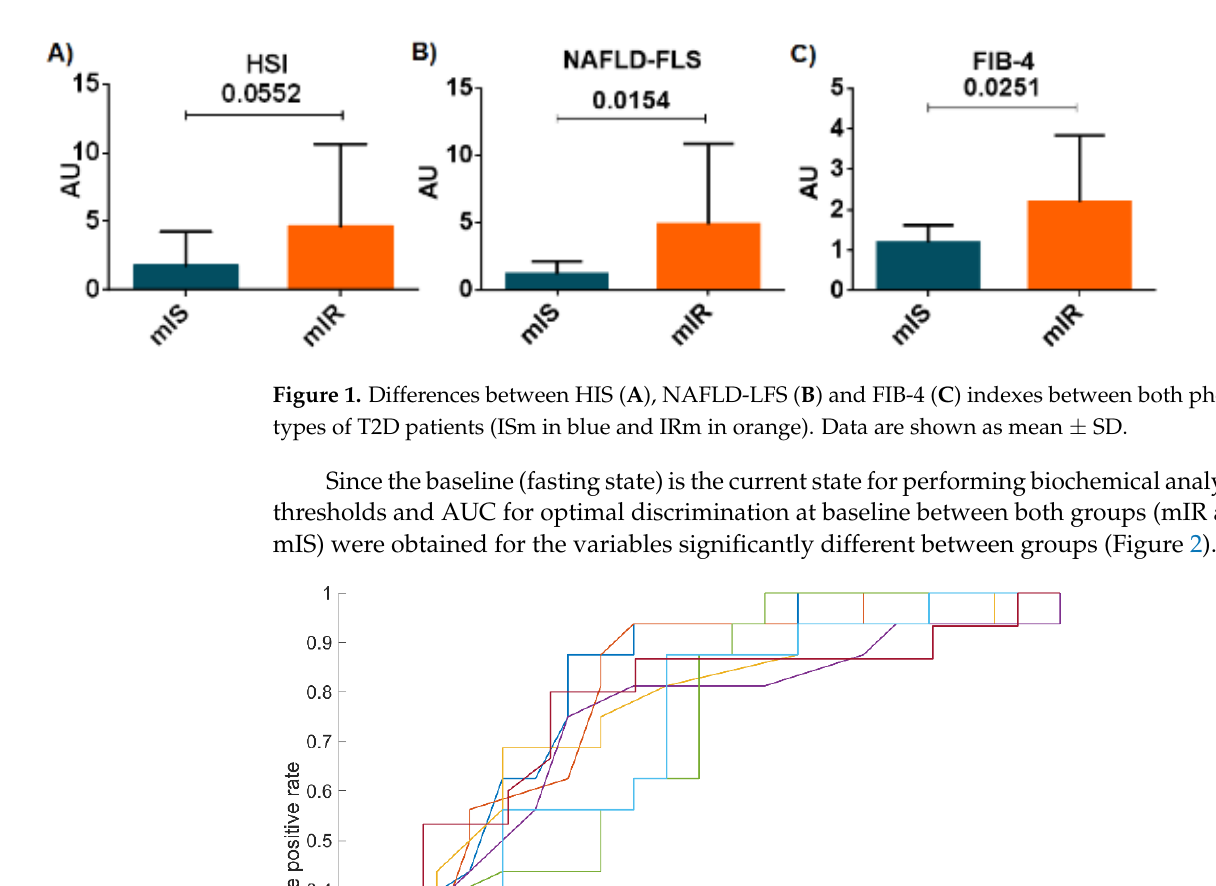
Figure 2. ROC curves of variables displaying the optimal threshold for splitting the two groups (mIR vs. mIS) together with their threshold and AUC values. The corresponding ROC metrics (sensitivity and specificity) are as follows: ALT (0.88, 0.68), AST (0.88, 0.64), GGT (0.69, 0.77), Protein (0.68, 0.75), FIB-4 (0.31, 0.95), and HOMA-IR (0.56, 0.77).